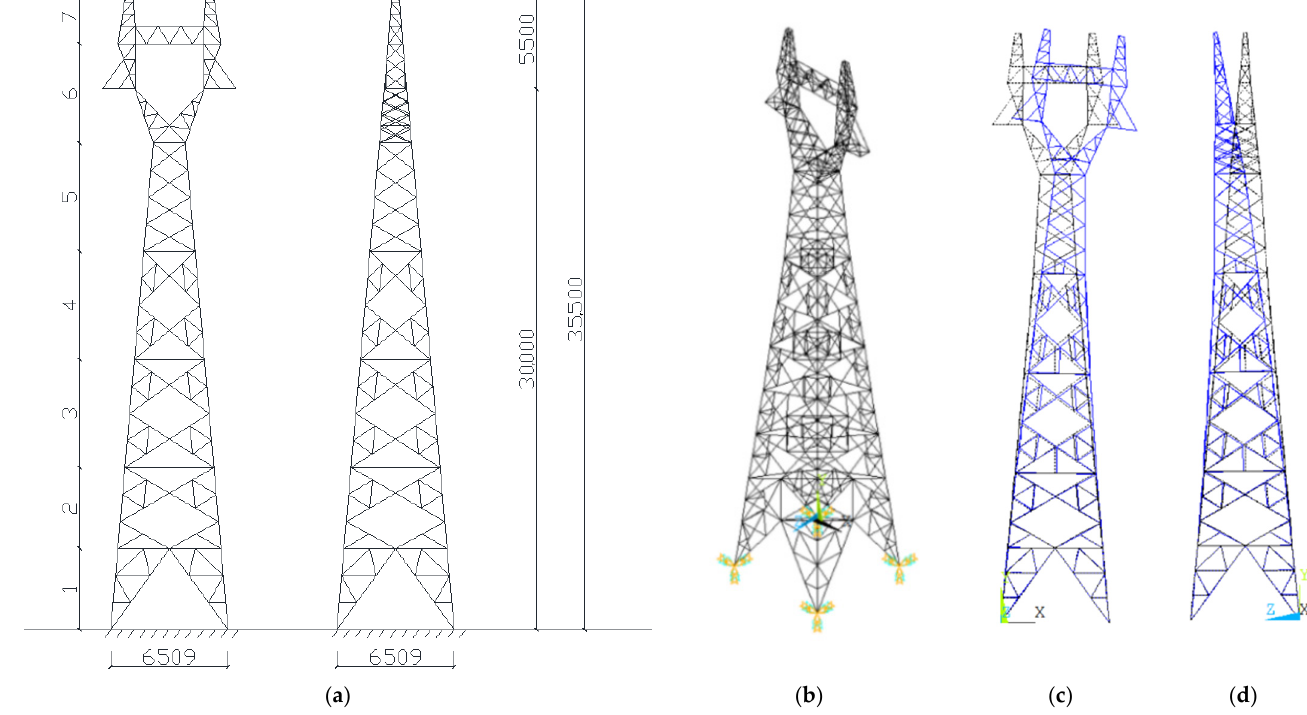
Figure 16. Schematic diagram of the transmission tower. ( a ) Single line diagram (unit: mm); ( b ) finite element model; ( c ) 1st mode f 1 = 3.33 Hz; ( d ) 2nd mode f 2 = 3.40 Hz.